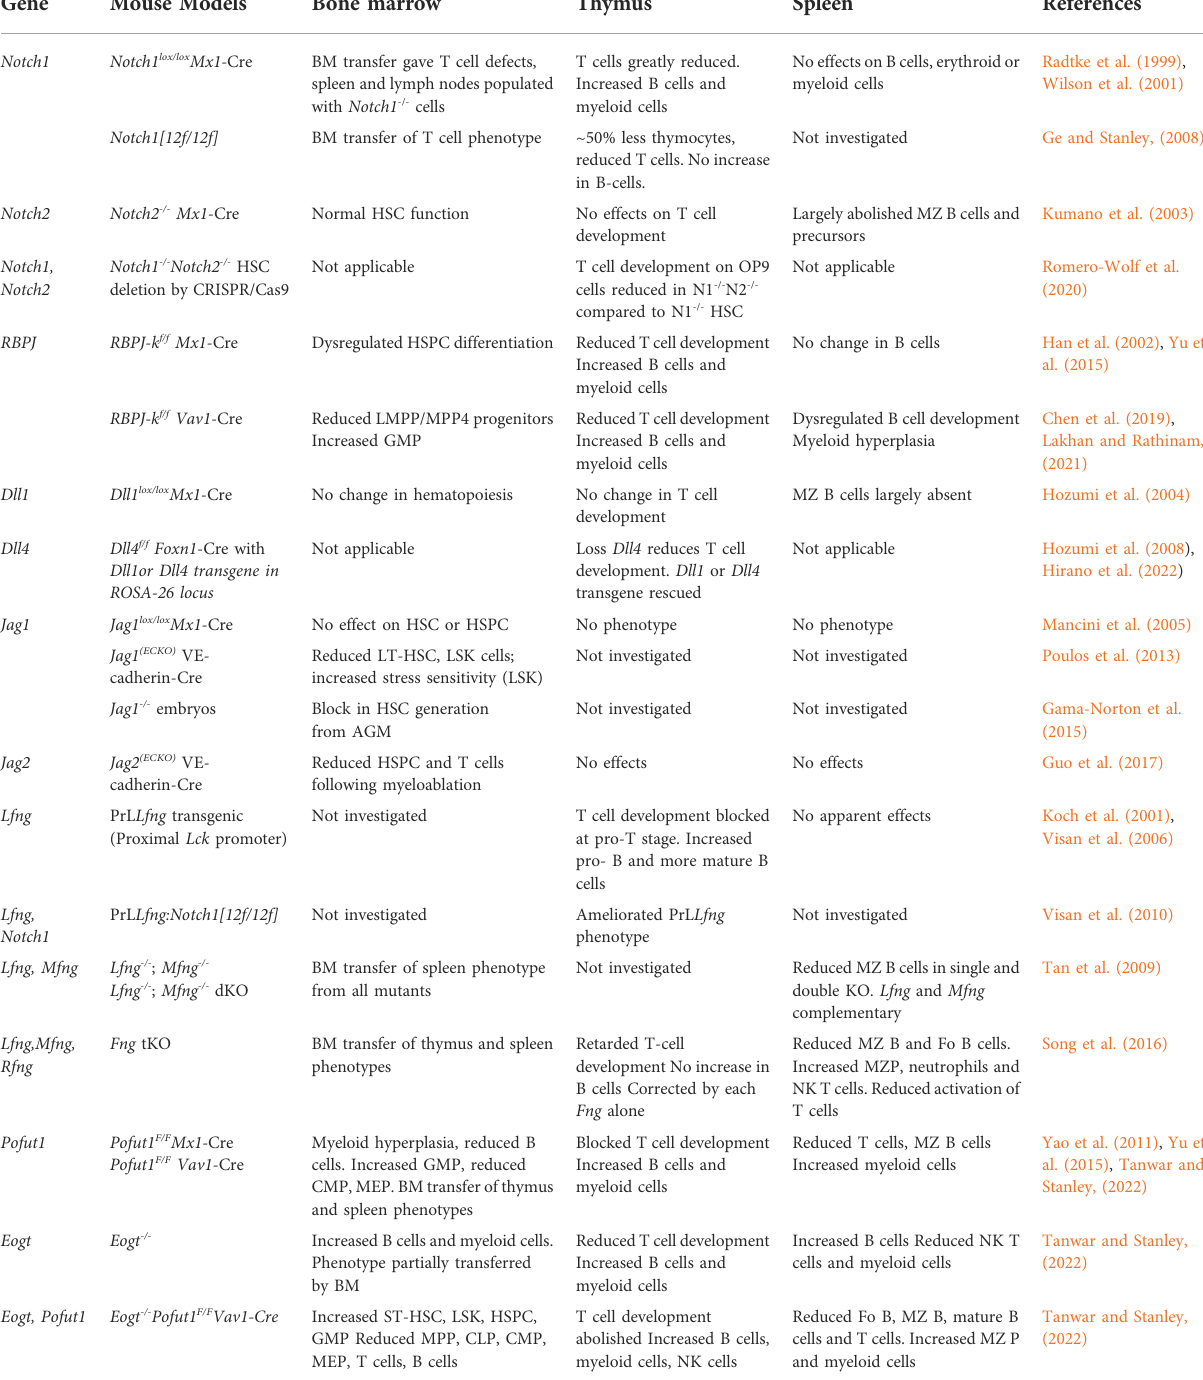
TABLE 1 Notch Signaling-Defective Mutants and